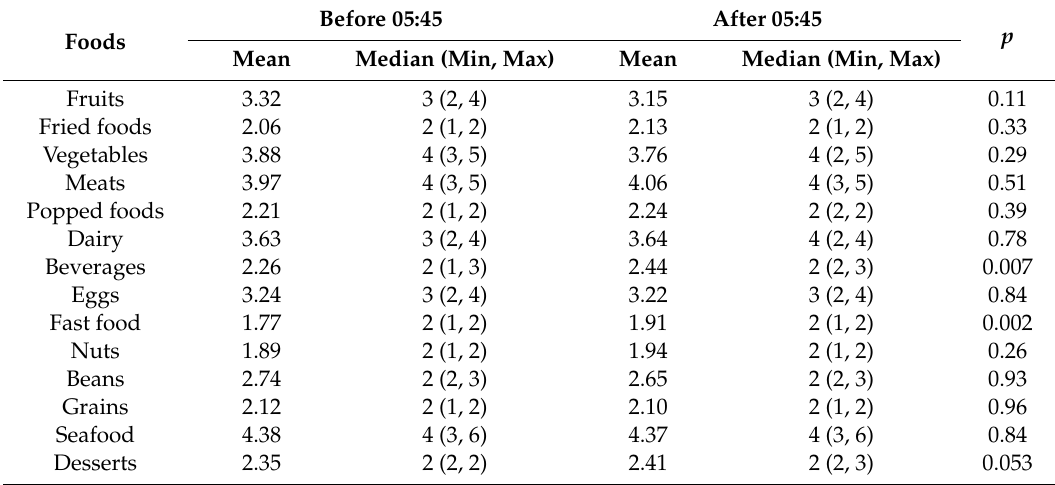
Table 5. Comparisons in food frequency across the waking up time group ( n =